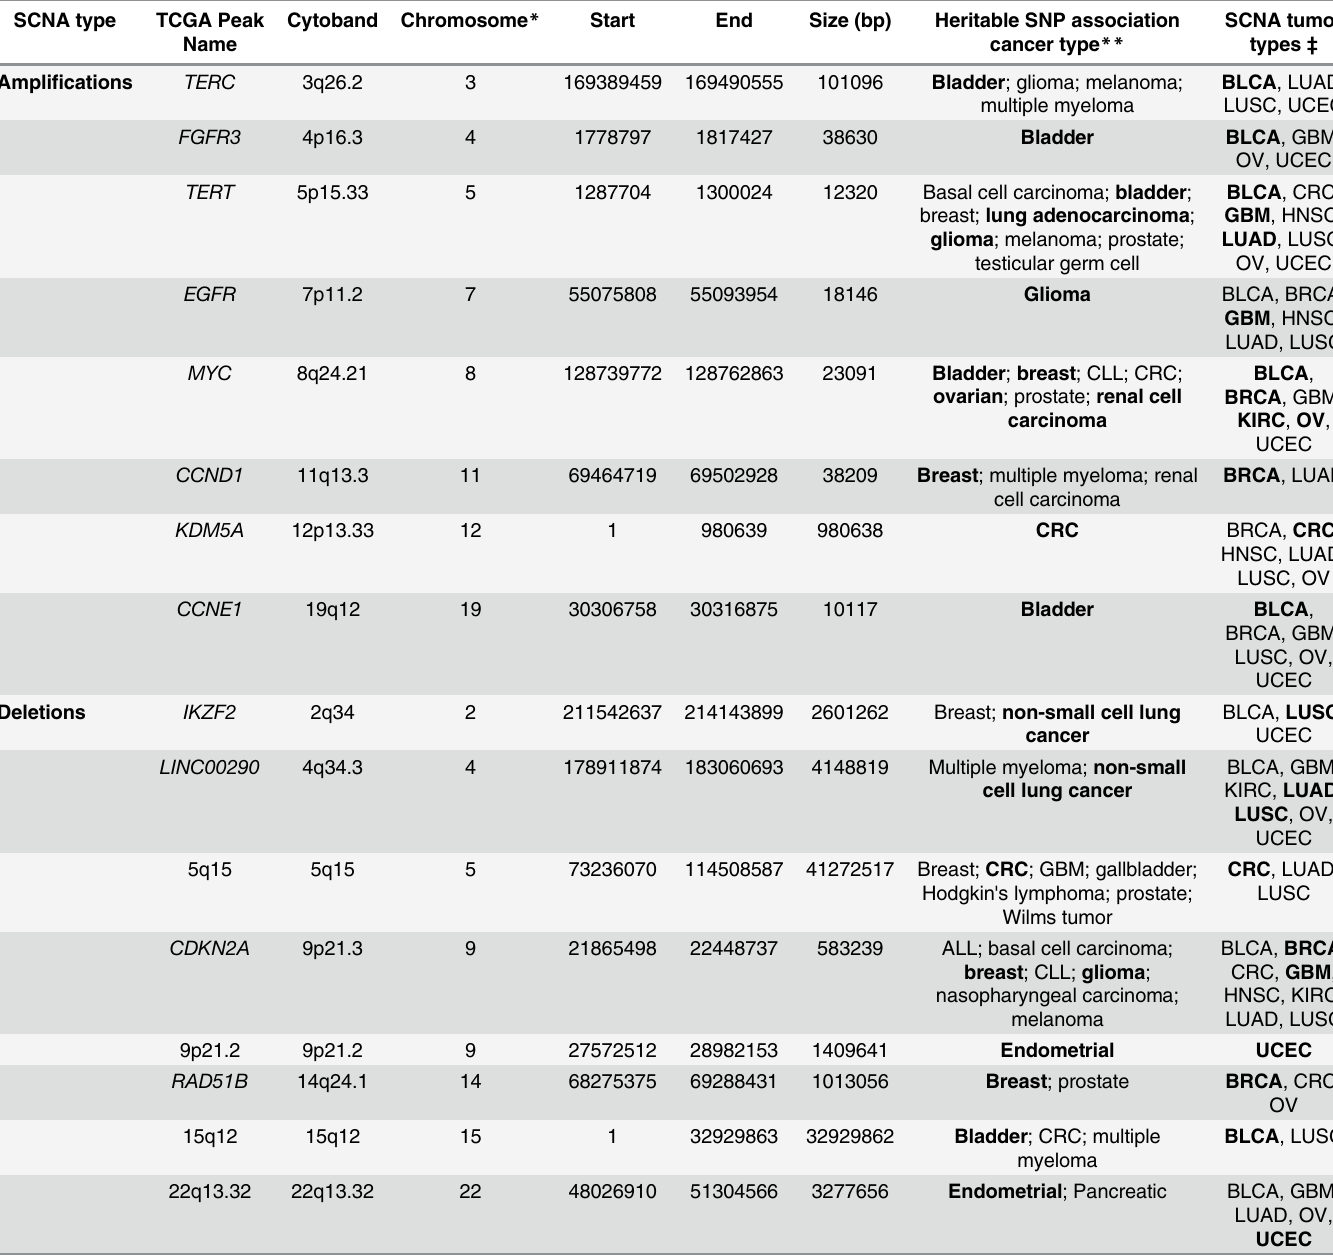
Table 2. Candidates for tumor PAI: recurrent SCNA loci from TCGA that overlap cancer-associated SNPs (NHGRI GWAS Catalog) identified in matching tumor